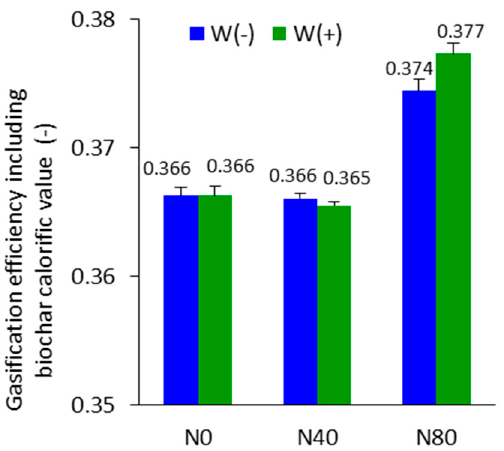
Figure 9. Process e ffi ciency including biochar formed after gasification. Figure 9. Process efficiency including biochar formed after gasification.